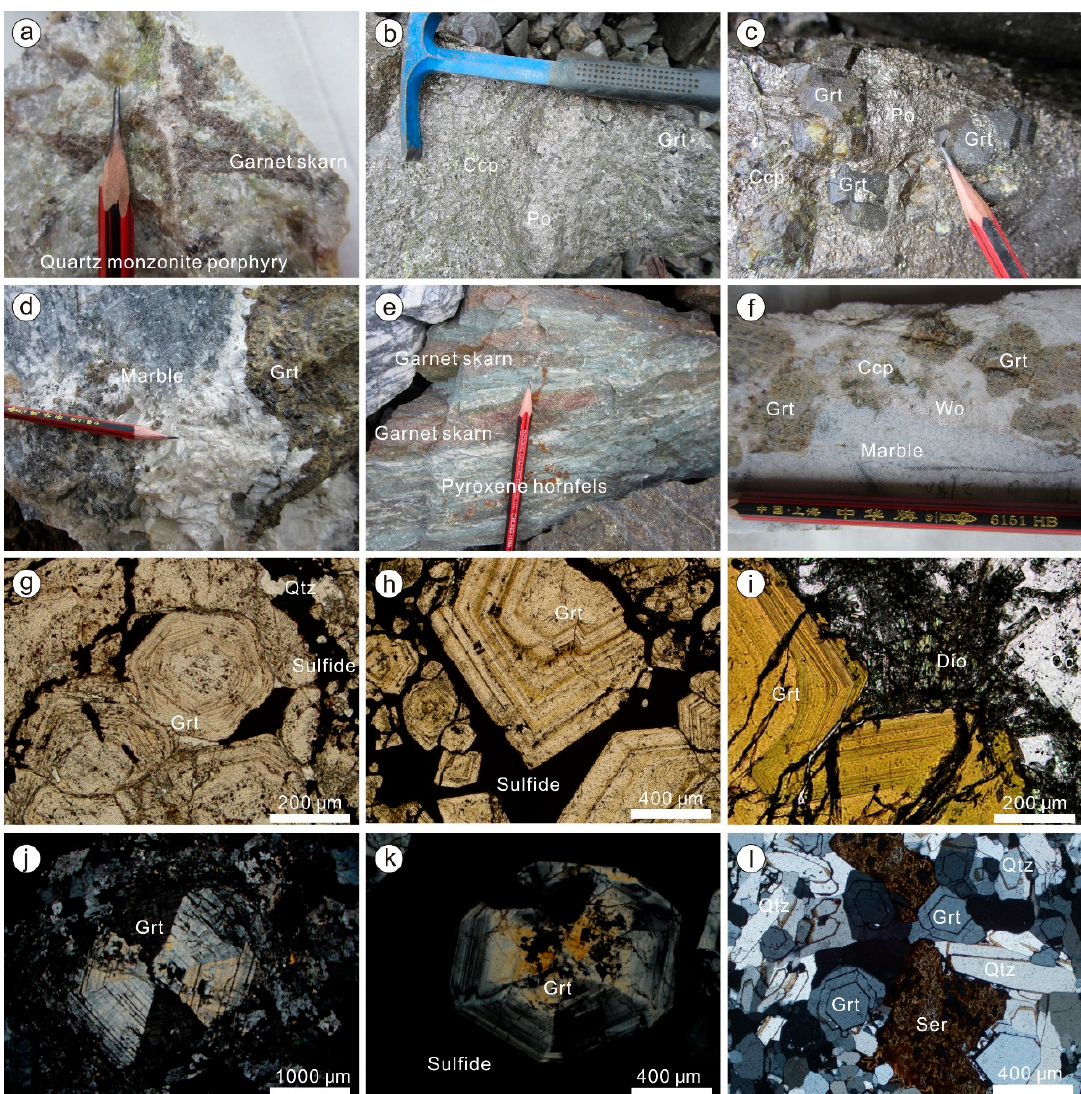
Figure 3. Photographs and photomicrographs showing characteristics of skarn ores in the Hongshan deposit. ( a ) Garnet in endoskarn in contact with residual quartz monzonite porphyry. ( b ) Massive or layered skarn ores with dense disseminated pyrrhotite in exoskarn. ( c ) Euhedral garnet in exoskarn ores with dense disseminated pyrrhotite and chalcopyrite. ( d ) Greenish-brown garnet in distal skarns along the marble. ( e ) Reddish-brown distal skarn in pyroxene hornfels. ( f ) Brown eduhedral garnet along with marble and wollastonite. ( g – k ) Garnets in the exoskarns are isotropic and euhedral, anisotropic, and display evident oscillatory zoning. ( l ) Garnet from distal skarn lacks of apparent oscillatory zonings. Ccp: chalcopyrite, Dio: diopside, Grt: garnet, Po: pyrrhotite, Qtz: quartz, Ser: sericite, Wo: wollastonite